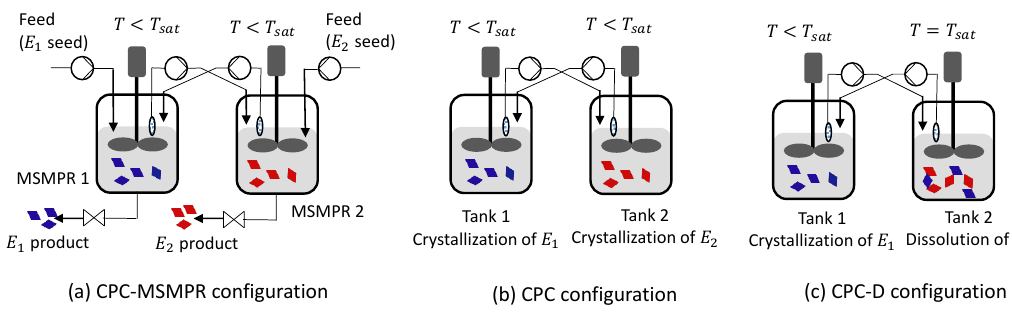
Figure 1. ( a ) CPC-MSMPR configuration, where the coupled MSMPRs initially containing supersaturated racemic solution are continuously fed with slurries that contain enantiopure seed crystals. The liquid phase exchange uses the depletion of the counter enantiomer in the other MSMPR. ( b ) CPC configuration, where crystallization of the opposite enantiomers takes place in two different tanks. It is similar to CPC-MSMPR except that there are no continuous feed and product removal. ( c ) CPC-D configuration, where preferential crystallization takes place in Tank 1. However, the Tank 2 which is seeded with racemic solid is maintained at saturation temperature leading to the selective dissolution of the counter